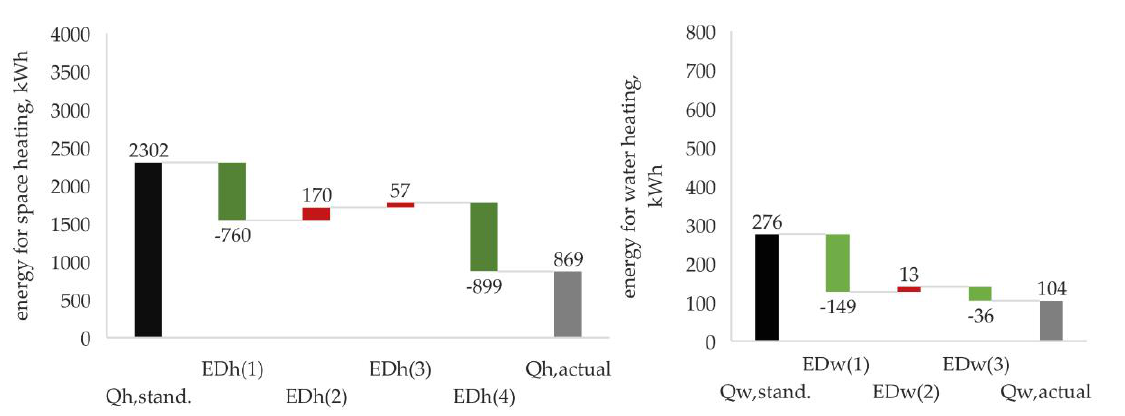
Figure 8. Influence of individual parameters on the values of energy consumption for heating ( Q h ) and hot water preparation ( Q w ) for unit D.